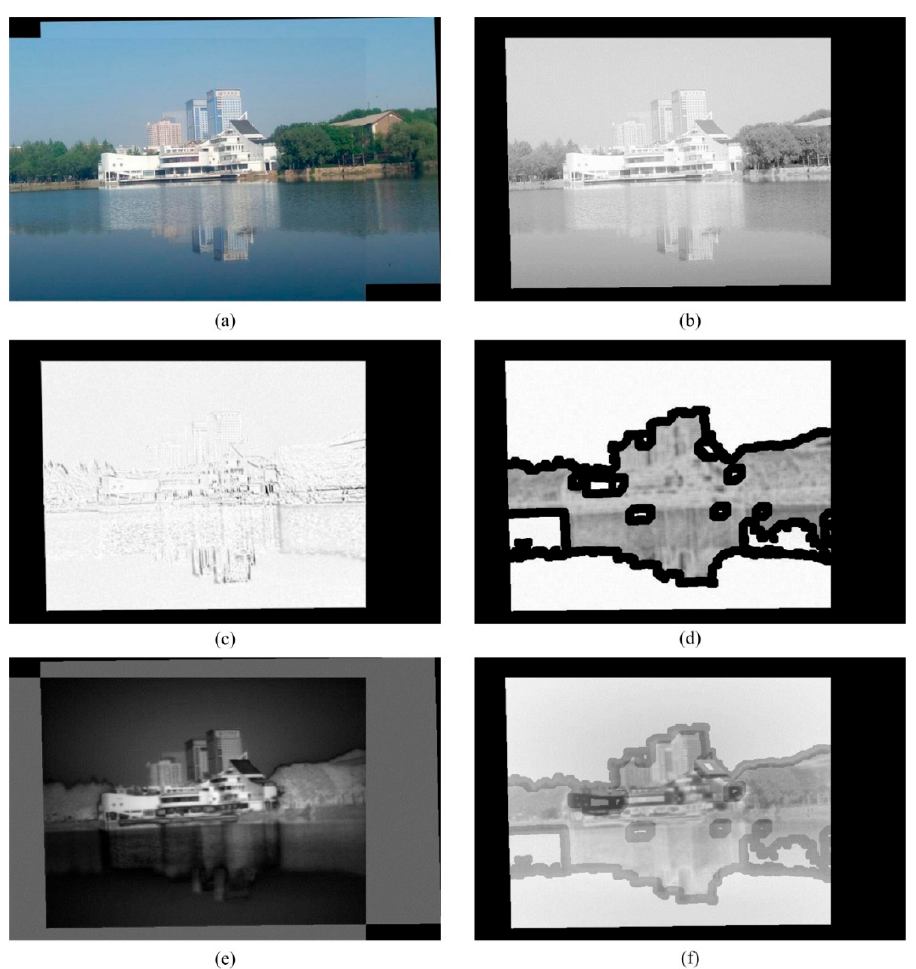
Figure 2. The results with different human visual system (HVS) properties. ( a ) Stitched image after affine transformation; ( b ) image just with visual non-linearity (VN); ( c ) image just with luminance difference (LD); ( d ) image just with visual masking property (VM); ( e ) image just with visual saliency (VS); ( f ) image with the integral HVS.